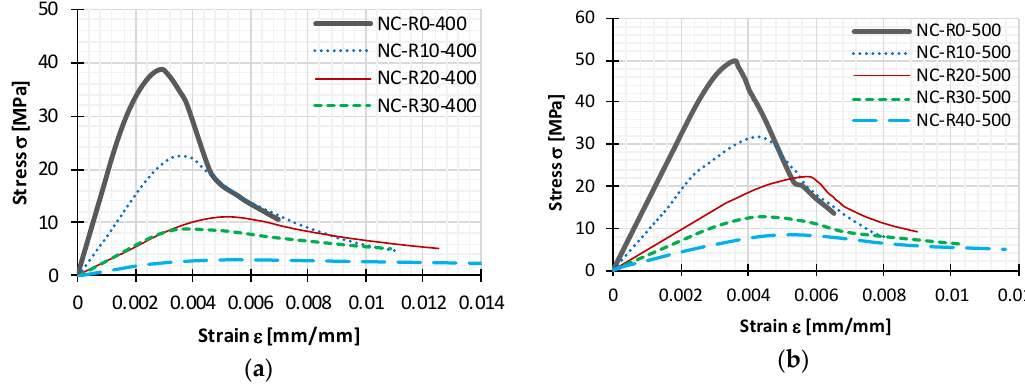
Figure 8. Compressive stress-strain curves for reference normal concrete (NC) and rubberized concrete (RC) with 10%, 20%, 30%, and 40% crumb rubber from ( a ) Series I and ( b ) Series II.